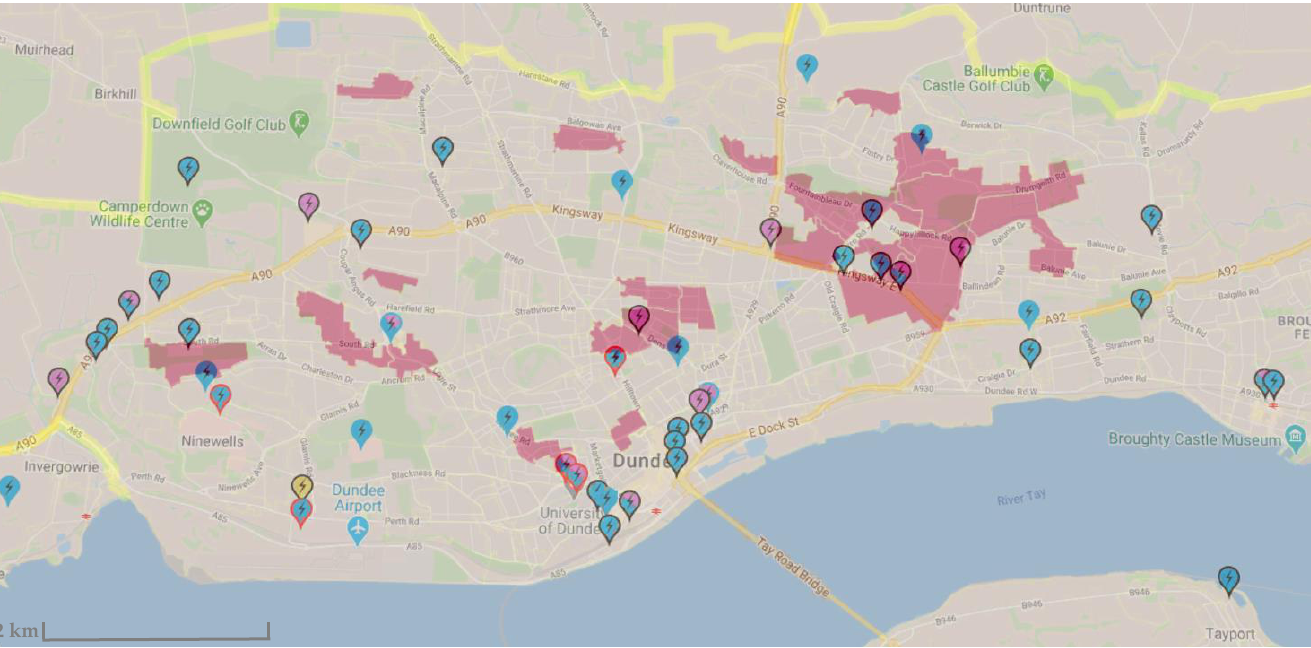
Figure 4. Dundee’s 5% multiple deprivation (red shaded) areas and location (icons) of EV infrastructure (sources: Scottish Index of Multiple Deprivation (SIMD), Google Map, Zap-Map (maps superimposed using Google Earth Pro)).